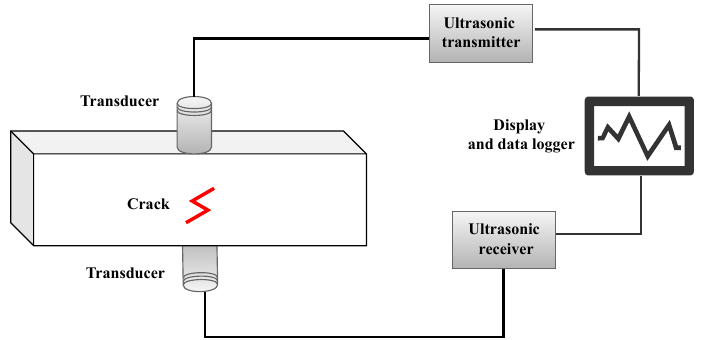
Figure 5. Principle of ultrasonic through-transmission